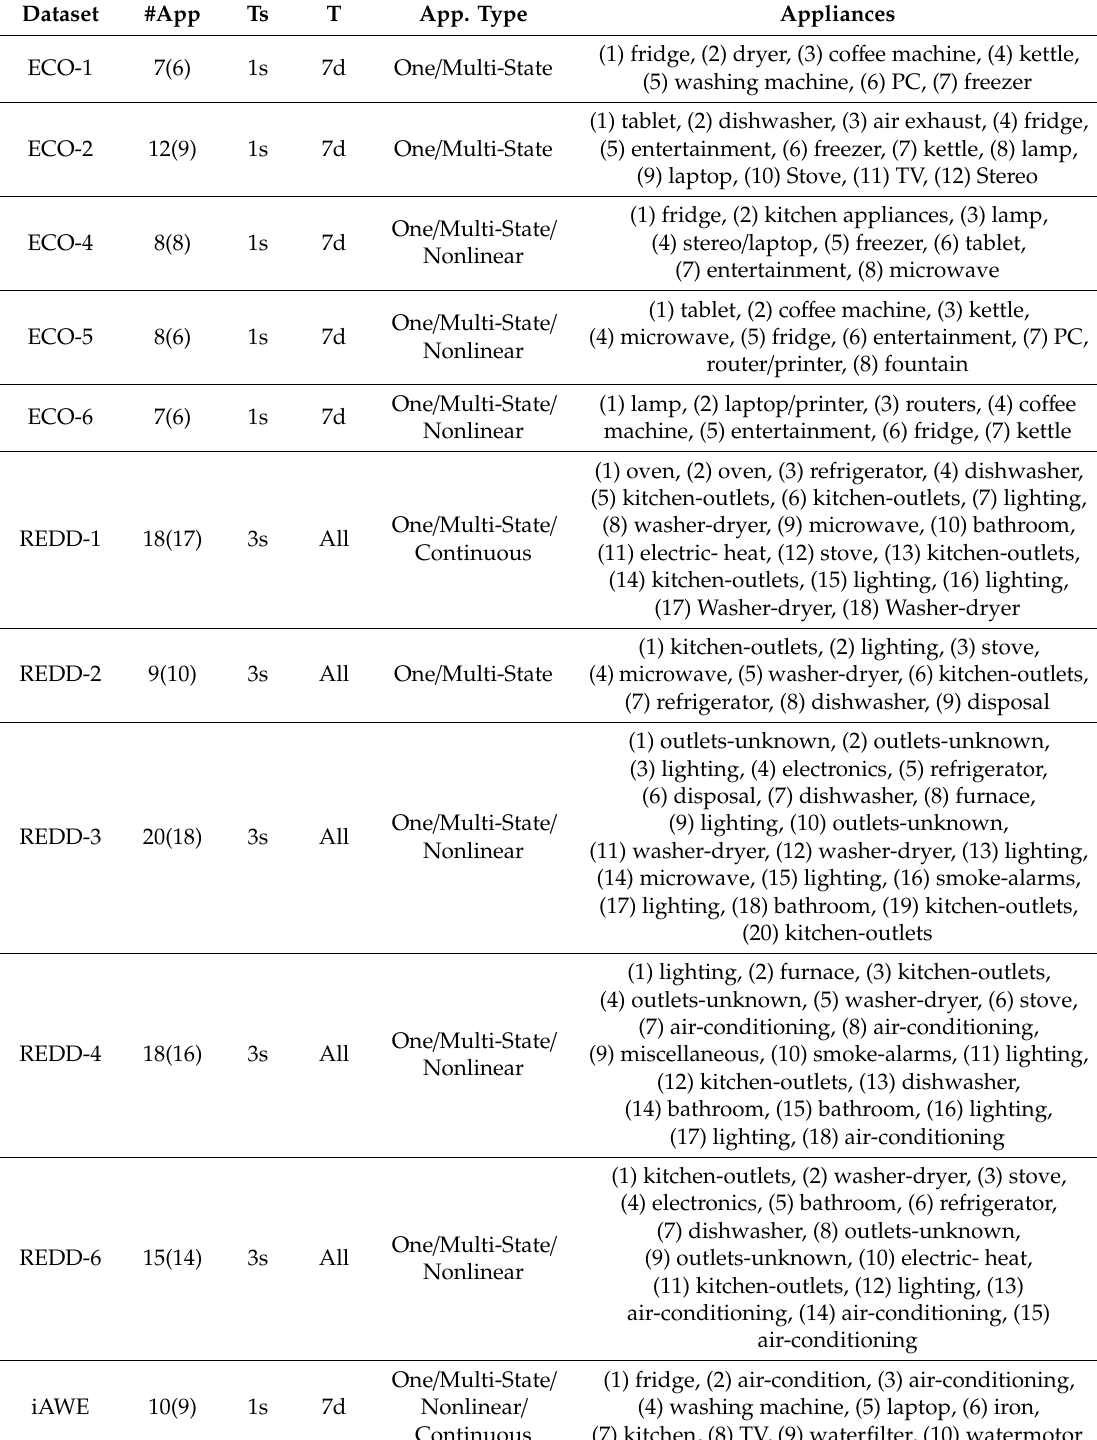
Table 1. Overview of the evaluated